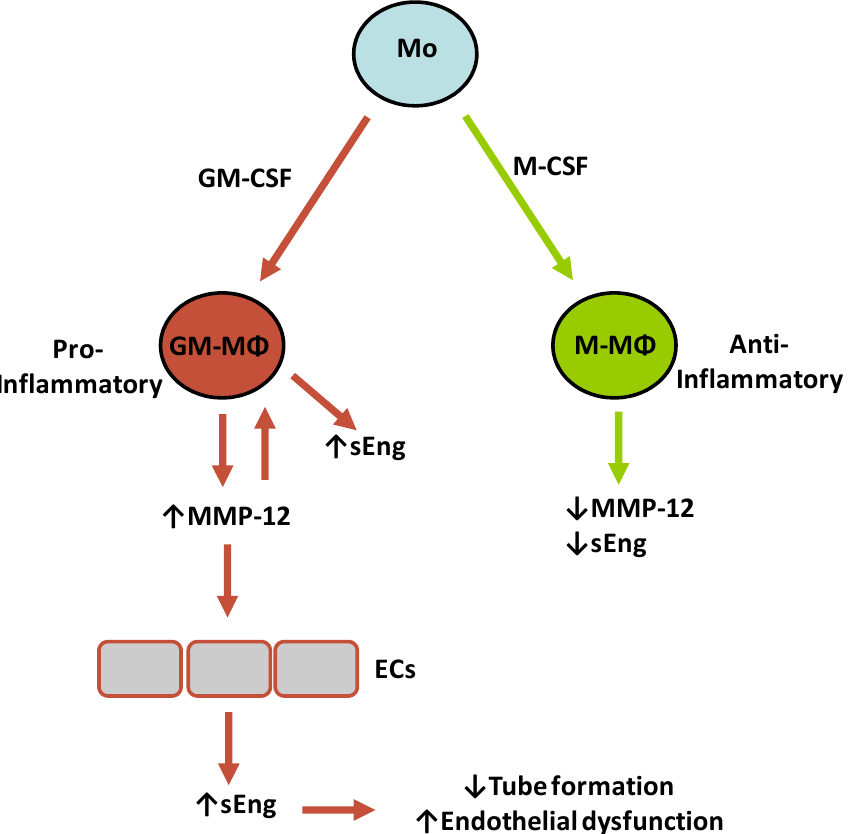
Figure 8. Hypothetical model for MMP-12 in sEng secretion and endothelial function. Circulating monocytes (Mo) can be polarized in the presence of GM-CSF or M-CSF, leading to pro-inflammatory GM-M Φ or anti-inflammatory M-M Φ , respectively. GM-M Φ , but not M-M Φ , secrete high levels of MMP-12, which in turn triggers the release of sEng in GM-M Φ and endothelial cells (ECs) by proteolytically cleaving membrane-bound endoglin. The e ff ects of sEng include inhibition of tube formation and a pro-inflammatory stimulus on ECs that may lead to endothelial